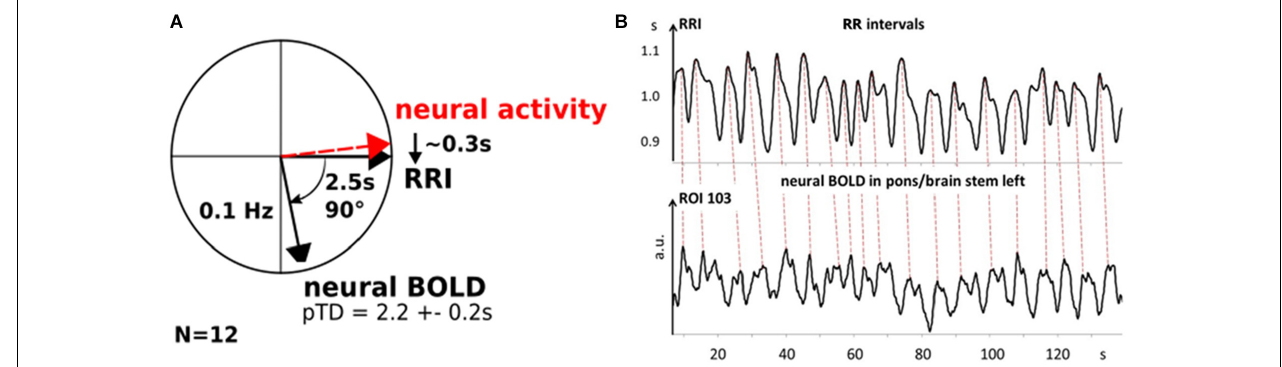
FIGURE 6 | Phasor representation of neural, RRI and BOLD oscillations from 12 subjects with a time delay of 2.2 ± 0.2 s between RRI and BOLD oscillations (A) . Neural oscillatory activity leads RRI oscillations by ∼ 0.3 s. B : Patterns of RRI recorded from thorax and BOLD oscillations in pons/brain stem from subject 11R1. Note, RRI oscillations recorded on thorax precede those in BOLD signals in left pons/brain stem (ROI 103) by ∼ 2.2 s (dashed